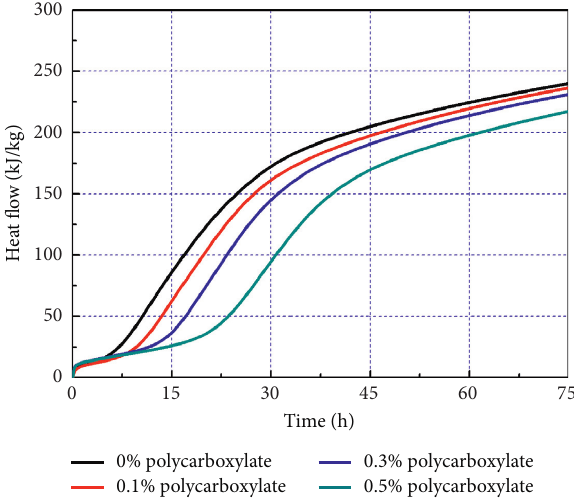
Figure 8: Effect of PCE-2 dosage on hydration heat of cement pastes with 10% fly ash.